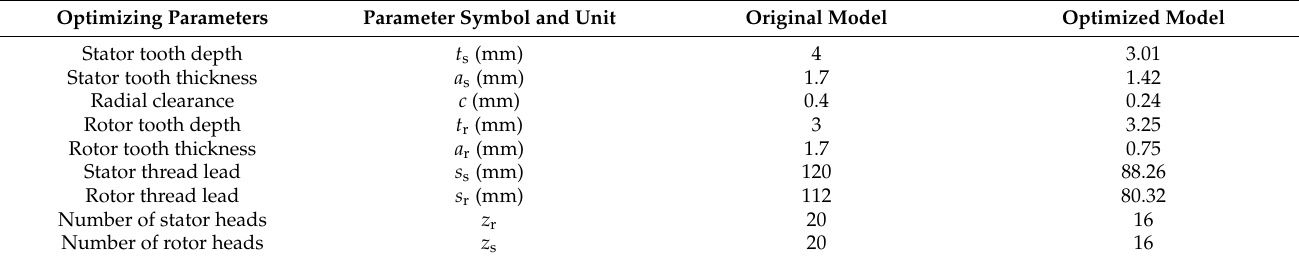
Table 5. Comparison of structural parameters of model pumps before and after